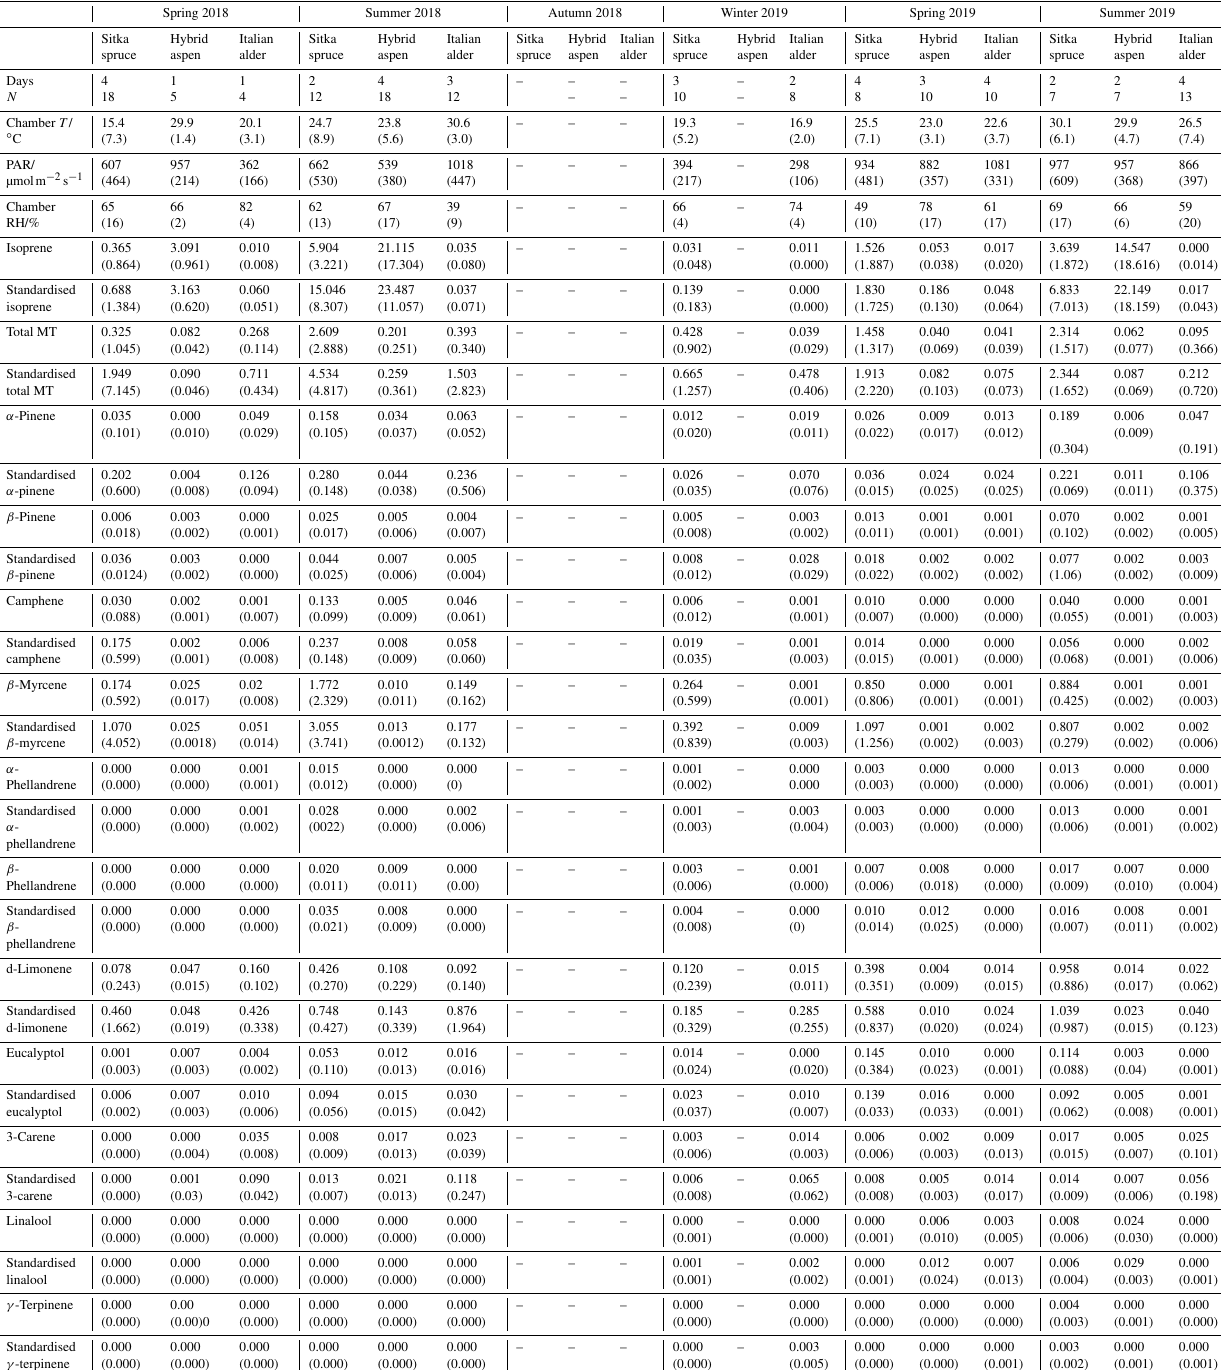
Table 4. Mean seasonal BVOC emissions (µgg − 1 h − 1 ) from branches of Sitka spruce, hybrid aspen and Italian alder in SRF plantations, dw East Grange, Fife, Scotland. Figures in parentheses are standard